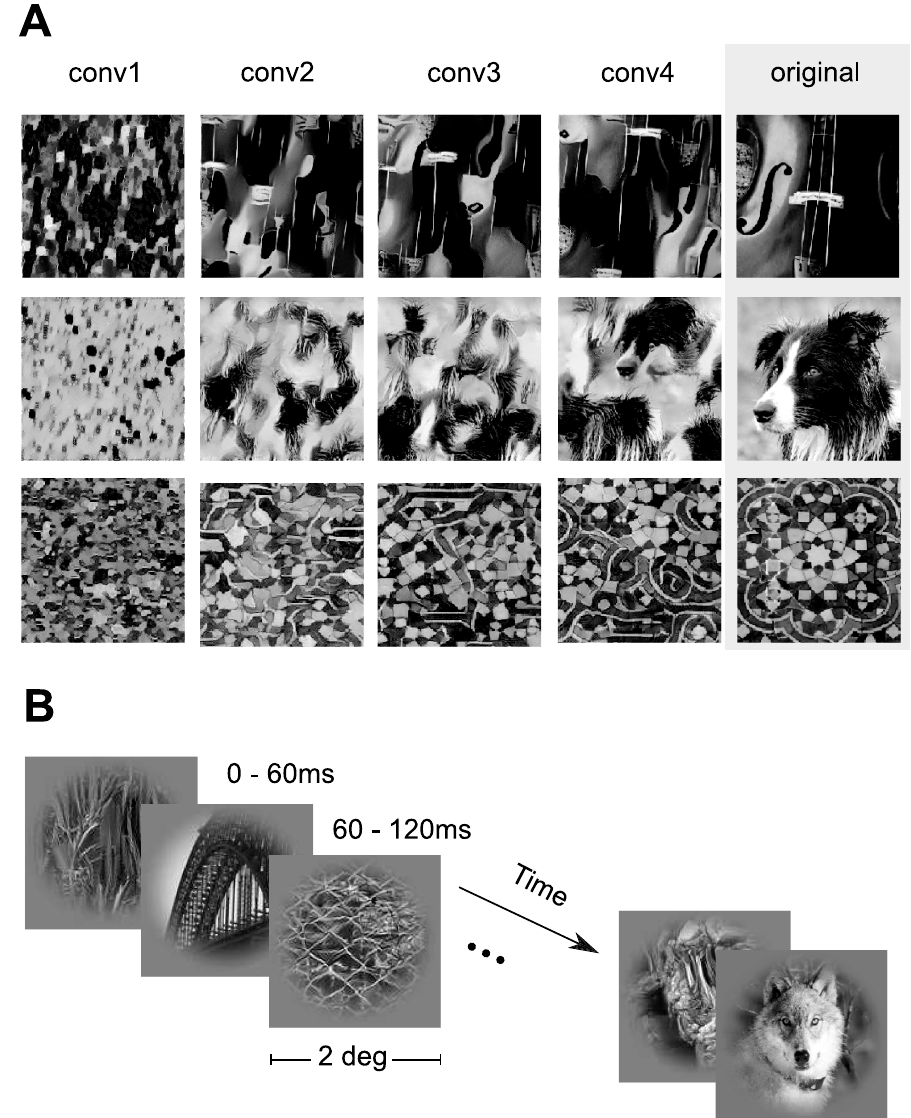
Fig 1. Stimulus paradigm. A: Classes of images shown in the experiment. We used grayscale natural images (labeled ‘original’) from the ImageNet dataset [44] along with textures synthesized from these images using the texture synthesis algorithm described by [45]. Each row shows four synthesized versions of three example original images using different convolutional layers (see Materials and Methods for details). Lower convolutional layers capture more local statistics compared to higher ones. B: Stimulus sequence. In each trial, we showed a randomized sequence of images (each displayed for 60 ms covering 2 degrees of visual angle) centered on the receptive fields of the recorded neurons while the monkey sustained fixation on a target. The images were masked with a circular mask with cosine fadeout.